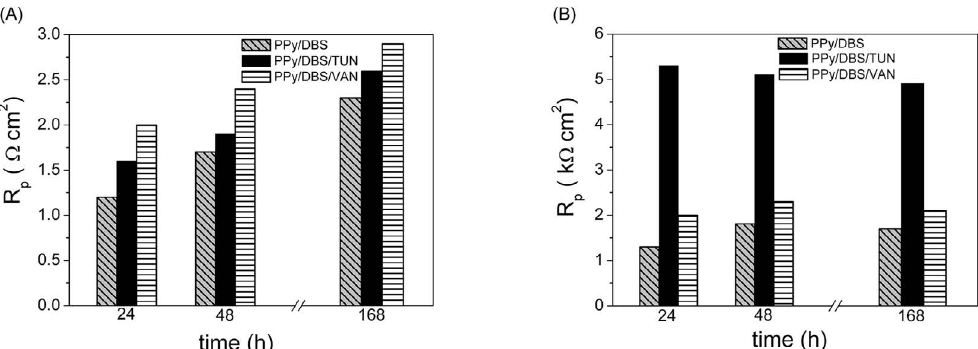
Figure 5. Variations of the overall impedance for the PPy films electrodeposited on the AA1100 substrate with immersion time in (A) 0.05 mol L -1 NaCl and (B) 0.05 mol L -1 HCl